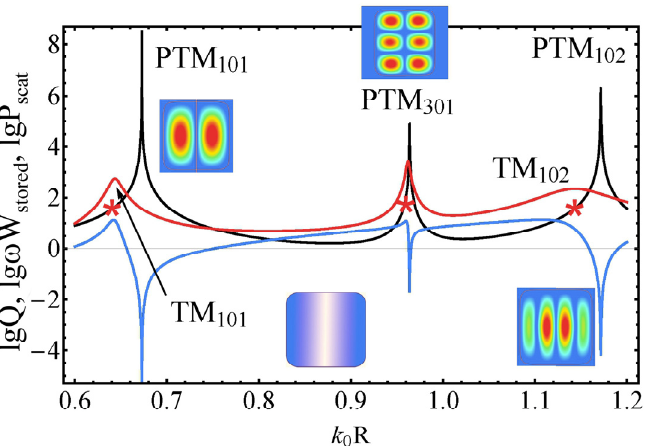
Figure 13. The dependence of logarithms of scattered power (blue), stored energy (red), and radiation quality factor Q = ω W stored /P scat (black) on the size parameter of a superspheroid with D/H = 0.96, t = 8 obtained as a result of the Comsol simulation. TM symmetric excitation (23), ε = 50, α = π /4. The insets show the field distribution of the perfect nonradiating modes and the cross-section of the investigated superspheroid. All maxima correspond to perfect nonradiating modes! The stars on the black curve show the Q factor values of the usual